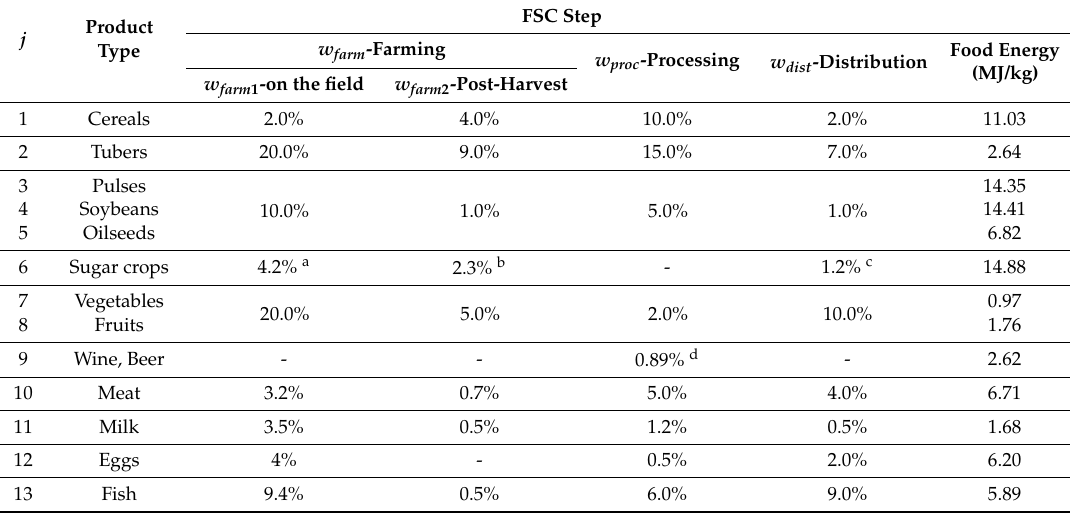
Table 3. Percentage of food losses and waste at different steps of the